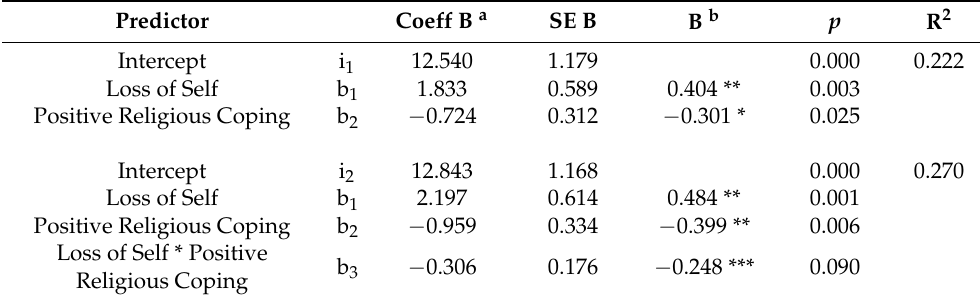
Table 5. Analysis of the moderating role of positive religious coping between loss of self and